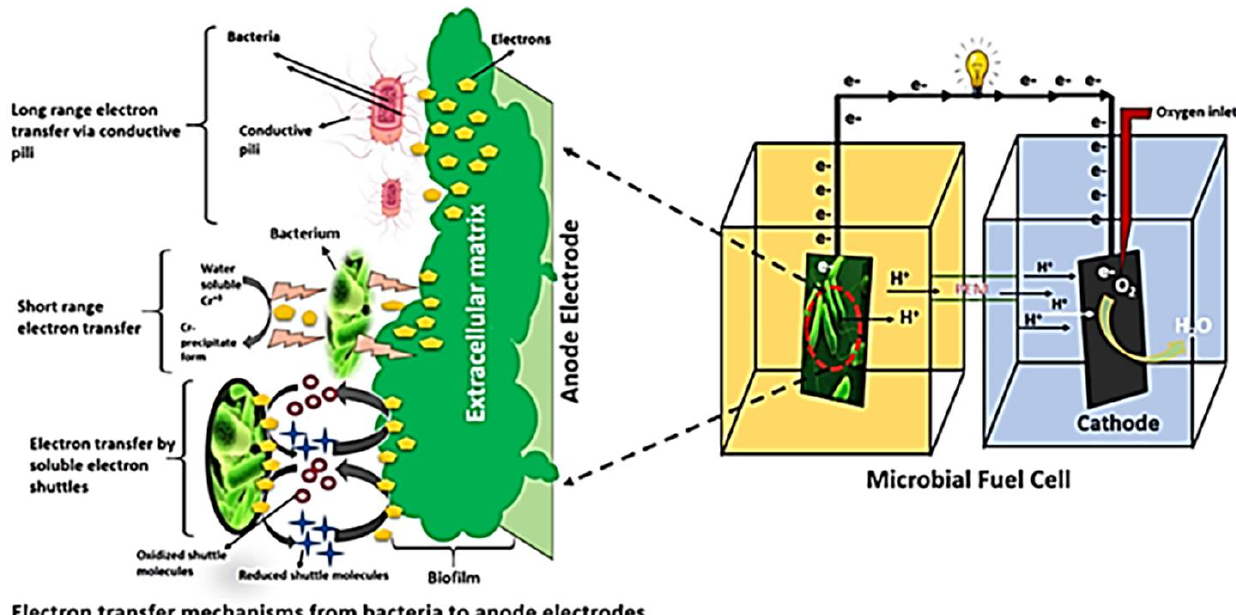
Figure 3. Mechanism of electron transportation from bacteria to anode in the microbial fuel cell [82]. Reproduced with permission from Elsevier.